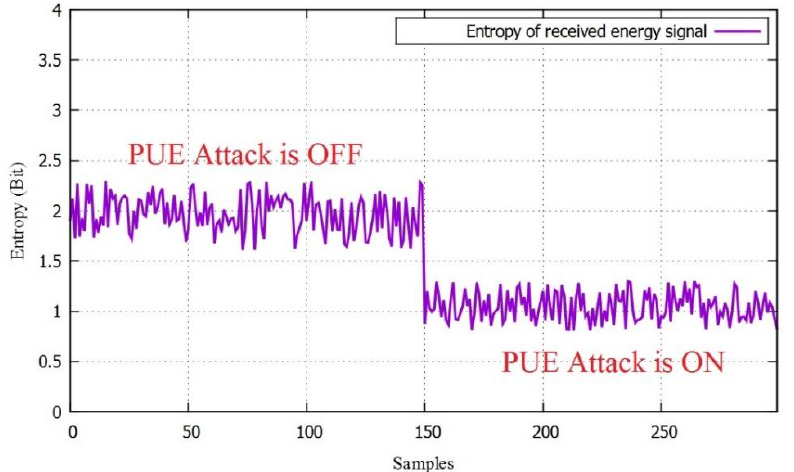
Figure 10. The entropy of the received energy signal.